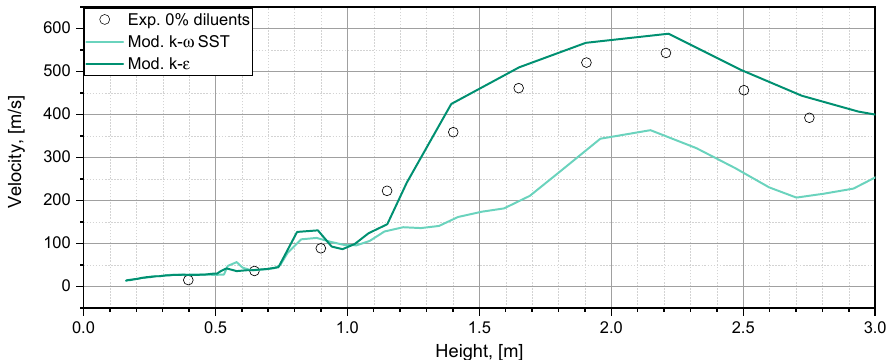
Figure 5. Comparison of turbulence models (Bradley correlation).